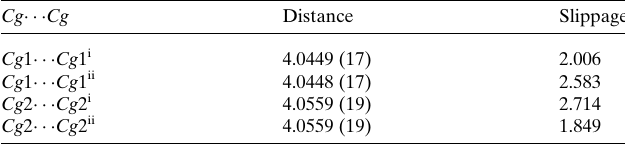
Table 3 (cid:2) – (cid:2) interactions (A˚ , (cid:3) ). Cg 1 and Cg 2 are the centroids of the C1–C6 and C1 B –C6 B rings, respectively. Cg (cid:2)(cid:2)(cid:2) Cg